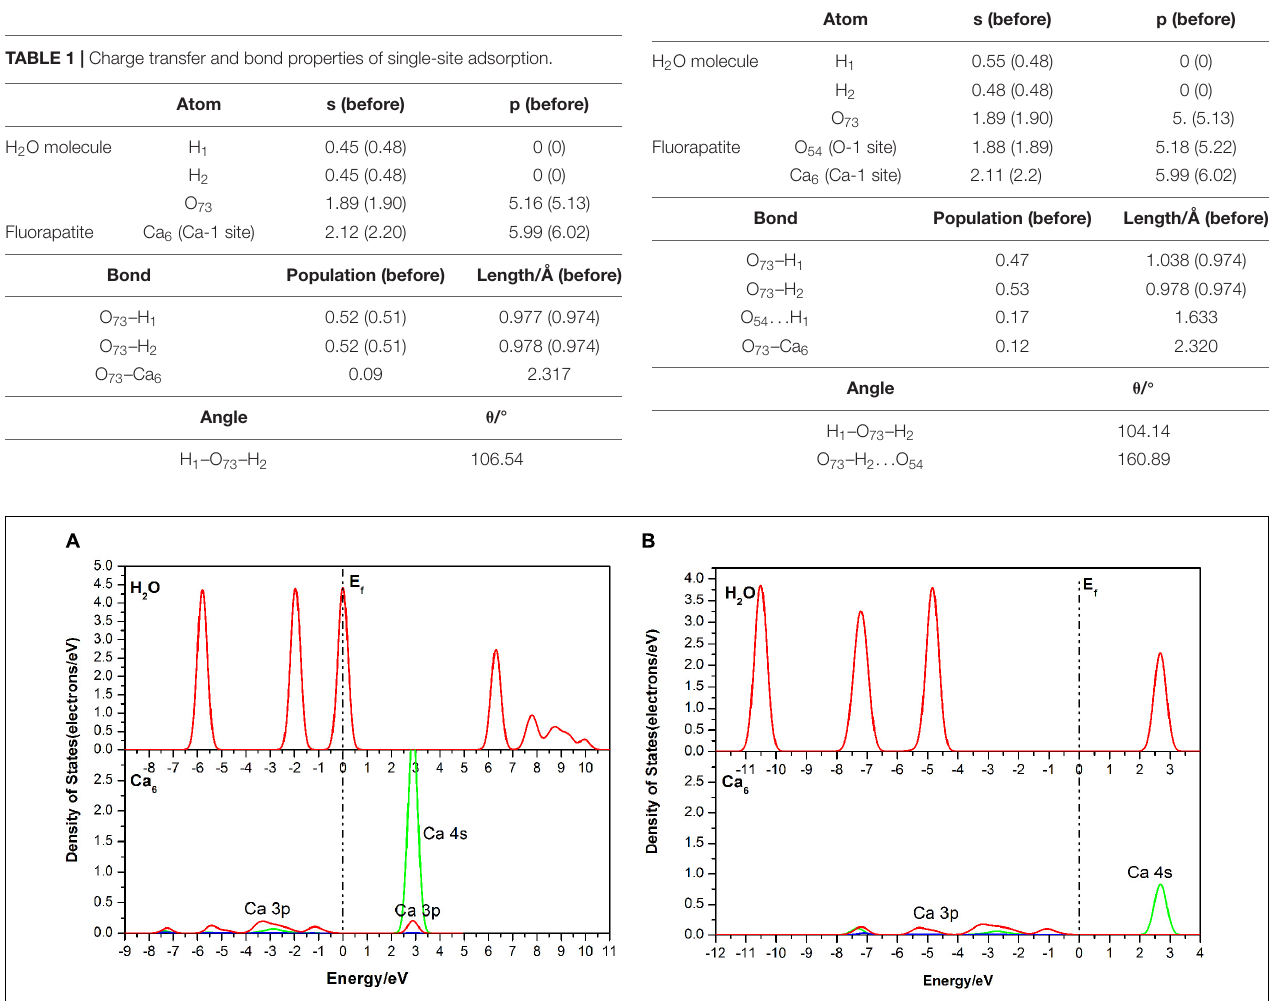
Frontiers in Materials |